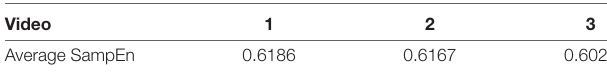
TABLE 3 | Average SampEn of three